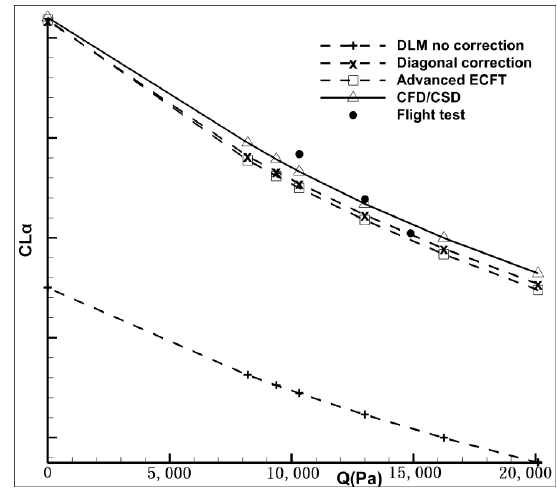
Aerospace 2023 , 10 , 40 Figure 12. Elastic C Lα at different dynamic pressures. Figure 12. Elastic C L α at different dynamic pressures.